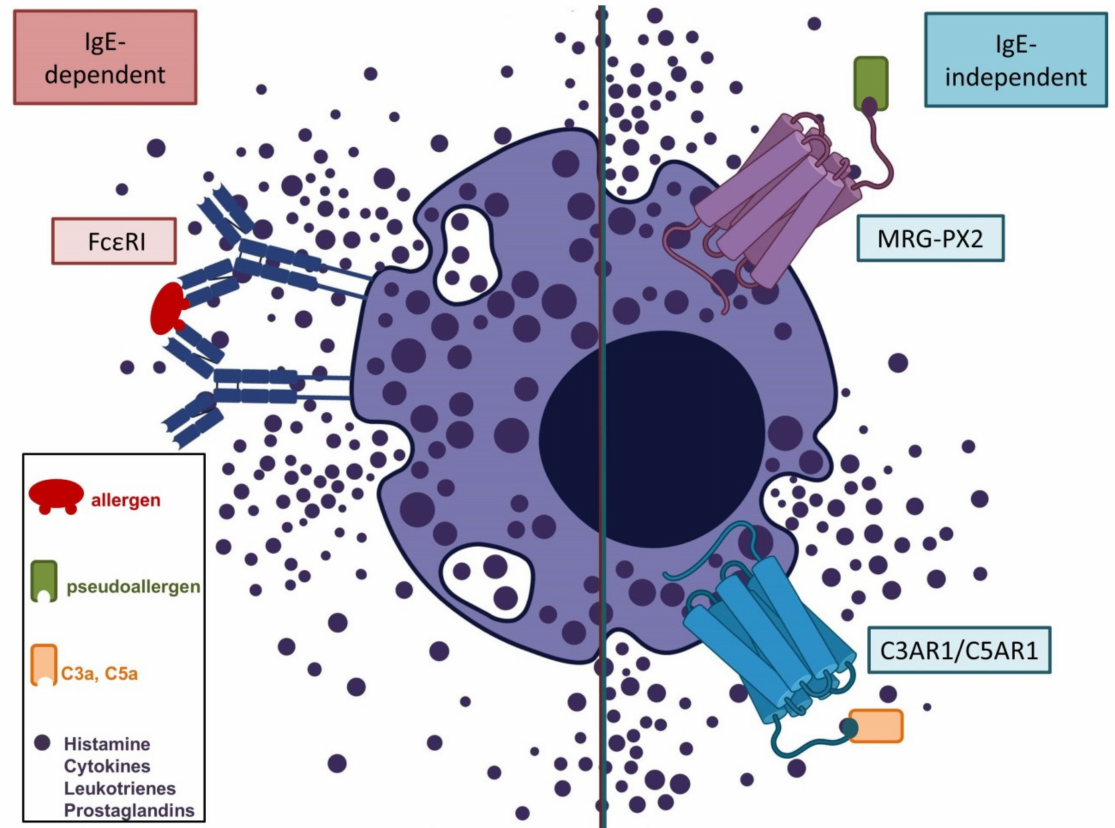
Figure 2. Supposed mechanisms of IgE-dependent (type I allergic) and non-IgE-dependent (pseudoallergic) immediate reactions to COVID-19 vaccines adapted from [27,30,32]. Type I allergic reactions occur due to dimerization of high-affinity IgE receptors (Fc ε RI) in sensitized individuals after contact with an allergen (e.g., PEGs). Non-IgE-dependent immediate reactions may occur via direct interaction of pseudoallergens with G-protein-coupled receptors (e.g., MRG-PX2), or as a result of complement activation (C3a, C5a) in individuals with specific IgG against components of the vaccine (e.g., anti-PEG IgG). Synchronized mast cell degranulation is the result of all three pathways, and causes an abrupt increase in blood levels of histamine, leukotrienes, prostaglandins, and other cytokines. Clinical symptoms such as angioedema, bronchial obstruction, and decreased blood pressure (shock) occur according to the extent of the anaphylactic/anaphylactoid reaction, and may be